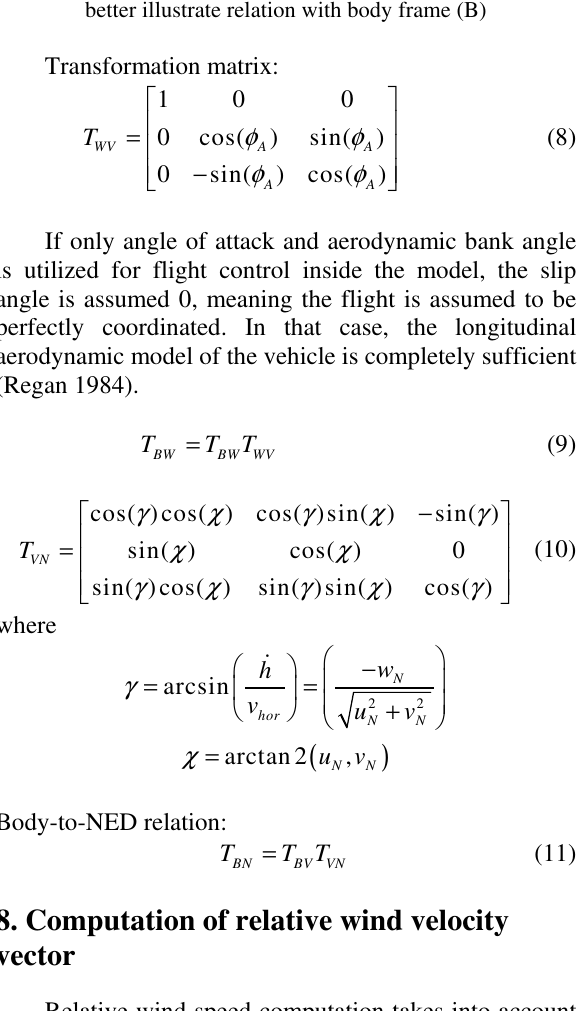
Fig 1. Definition of aerodynamic angles used for attitude definition on relative wind reference frame (Zipfel 2001)